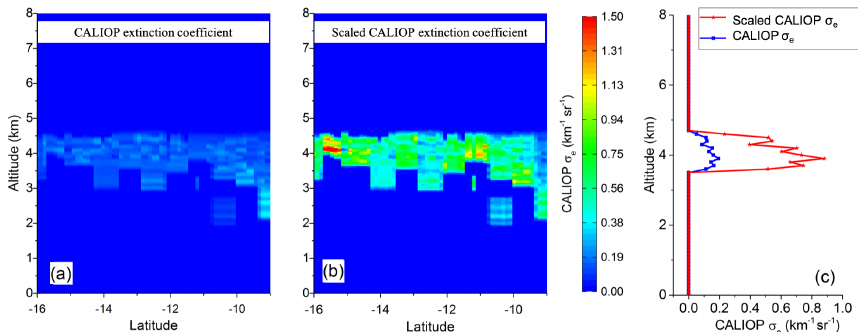
Figure 1. Biomass burning study case: (a) CALIOP initial extinction coefficient (m − 1 ) at 532nm ( σ e , 532nm ), (b) scaled CALIOP σ e , 532nm as a function of latitude; (c) example of CALIOP extinction coefficient profile at 532nm (blue) and the result of scaling (red) with the POLDER AOT extrapolated at